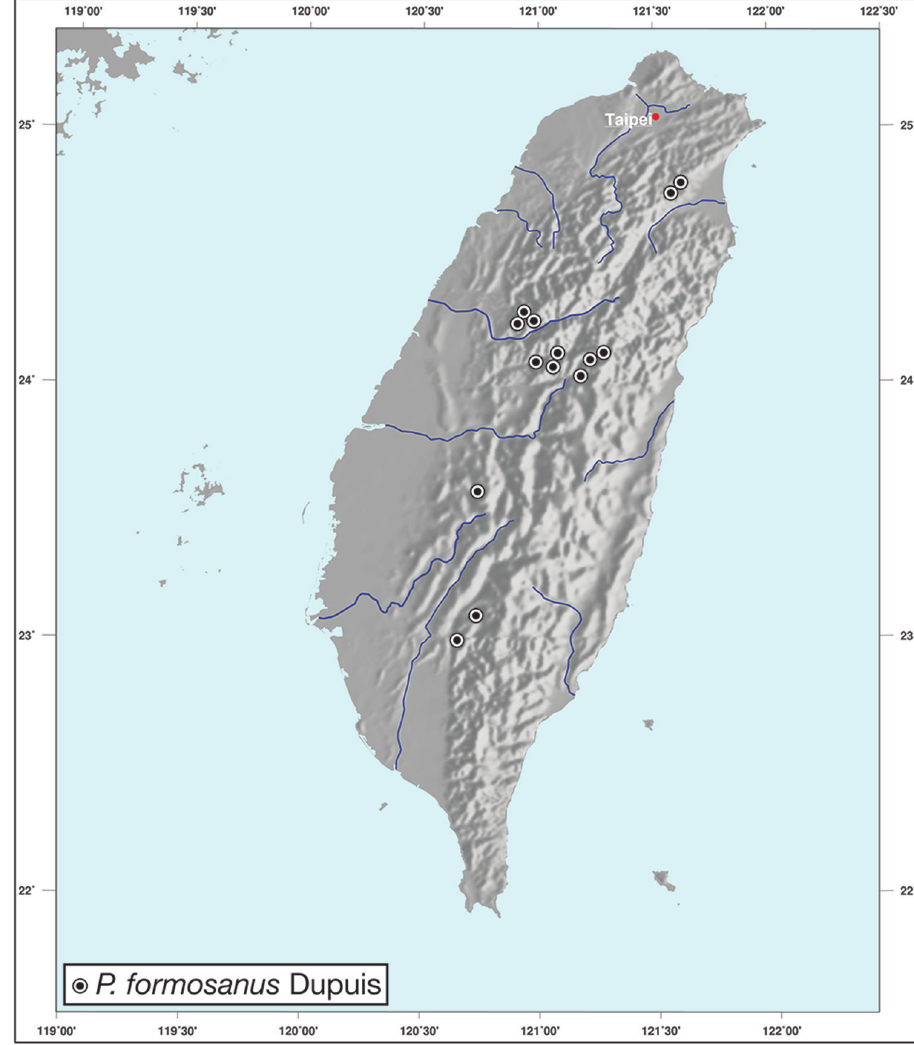
Figure 106. Map showing known localities for species of the genus Pericalus MacLeay, in Taiwan.